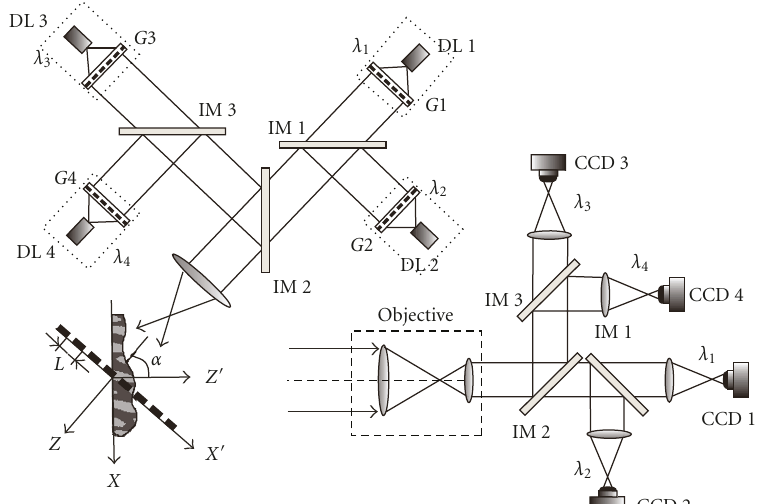
Figure 1: Optical arrangement of the four-wavelength pattern projection system—DL1-4: diode lasers, G1-4: di ff raction gratings, IM1-3: interference